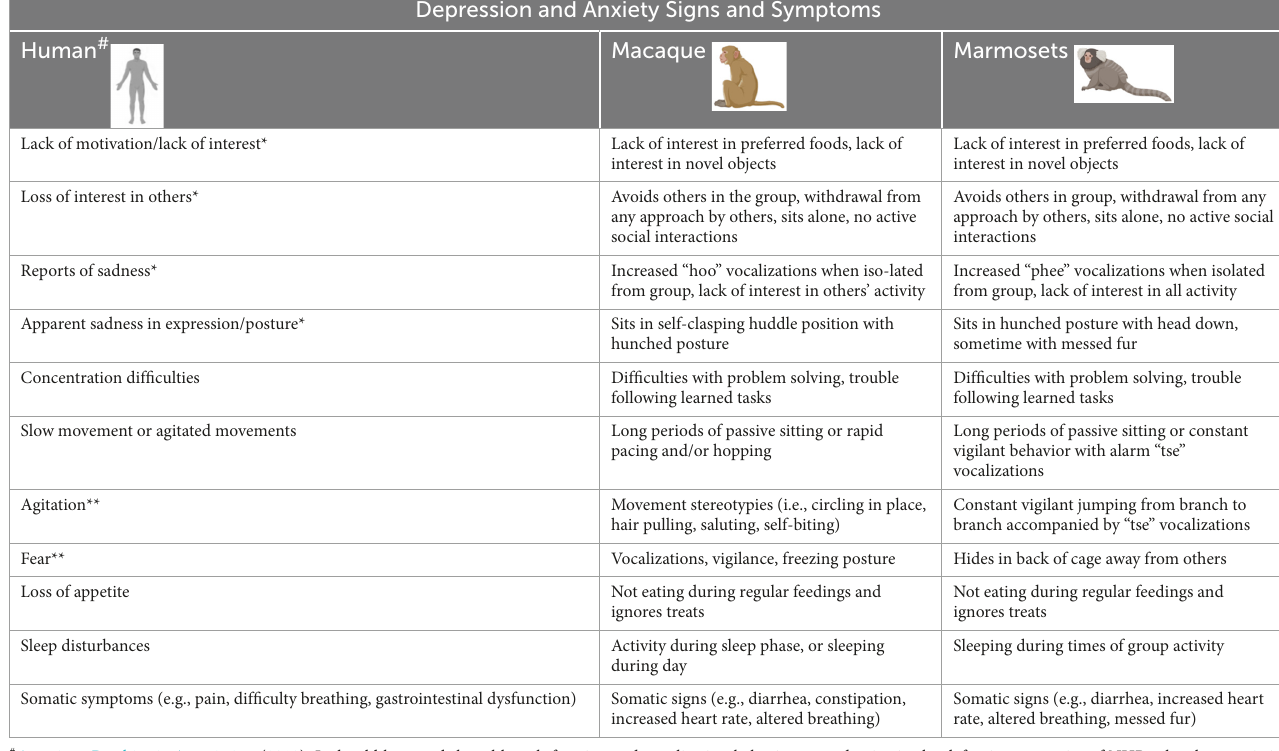
TABLE 1 Human signs and symptoms of depression and anxiety and their equivalent non-human primate (NHP) depression- and anxiety-like